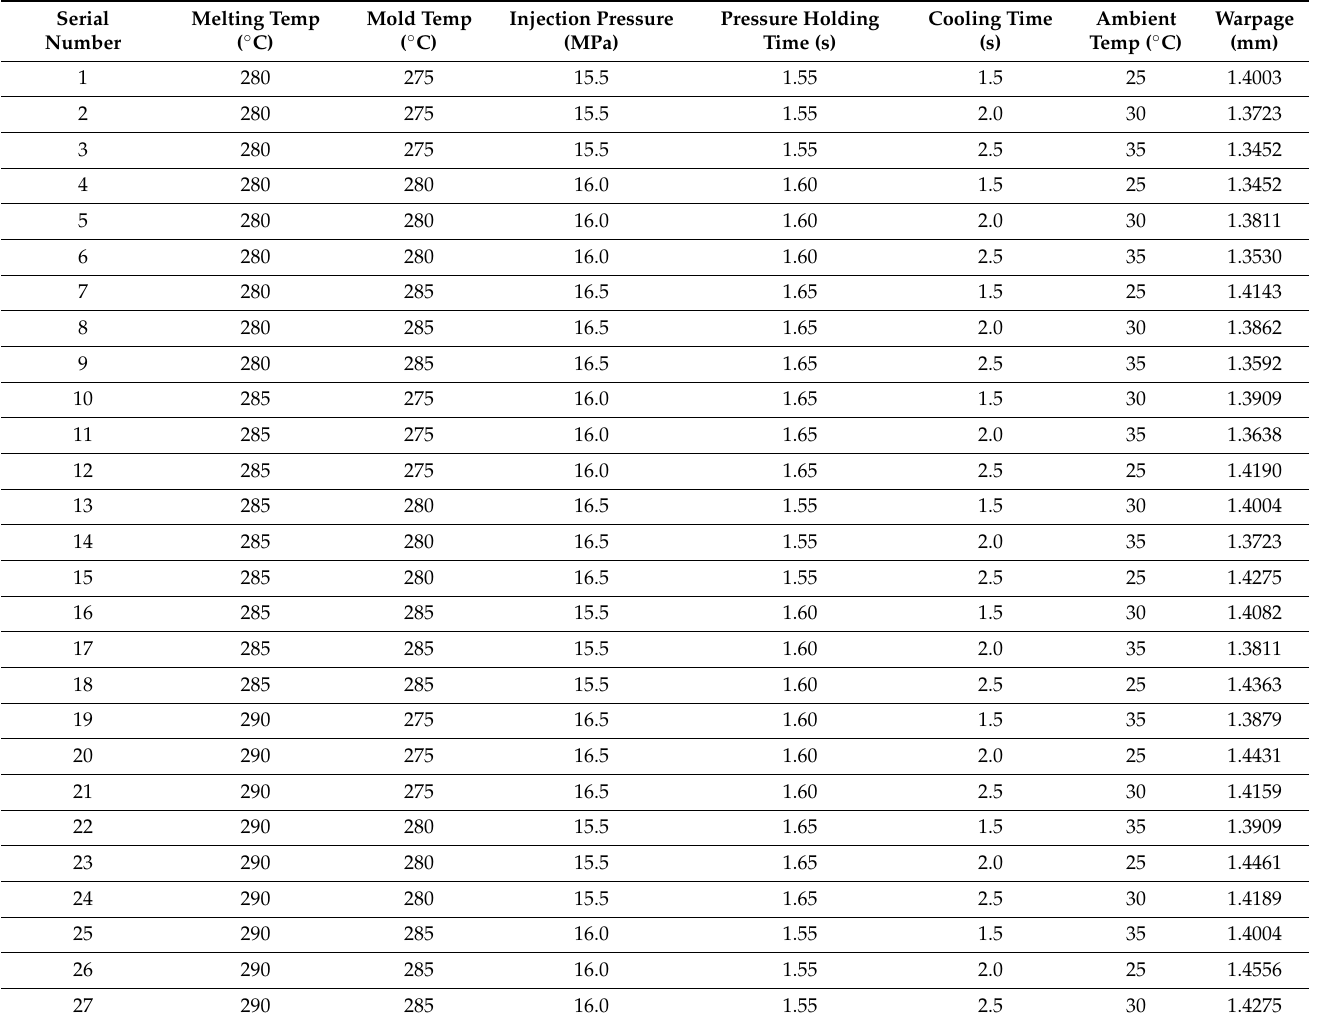
Table 3. Taguchi Array for Warpage